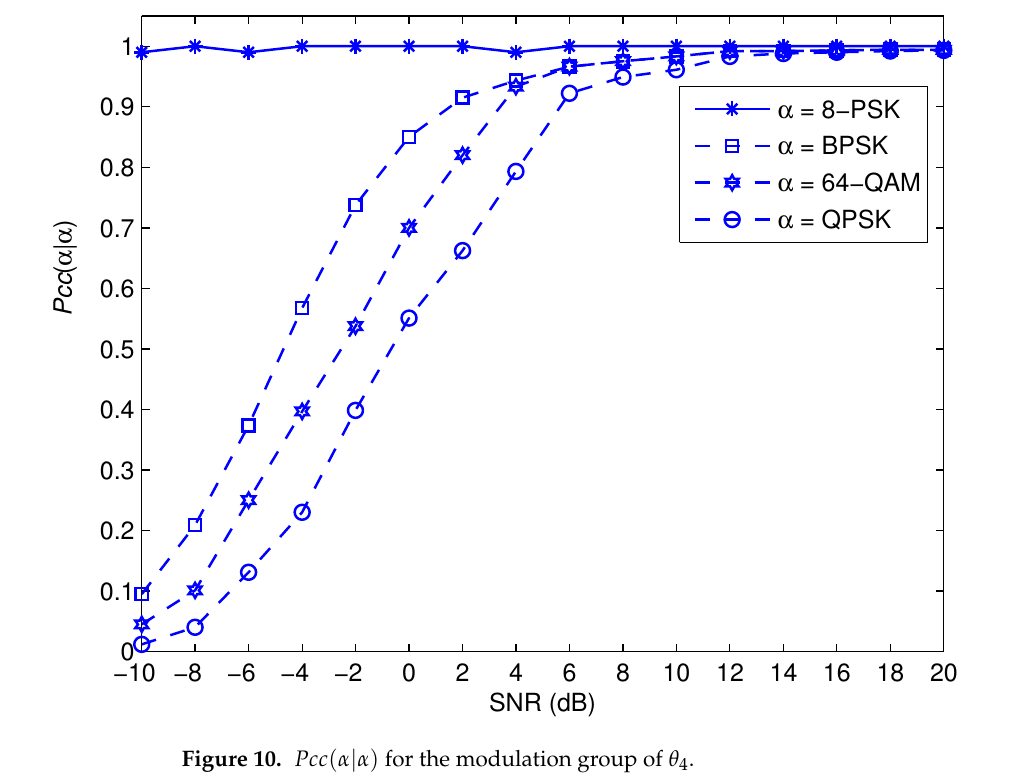
Figure 10. Pcc ( α | α ) for the modulation group of θ 4 .